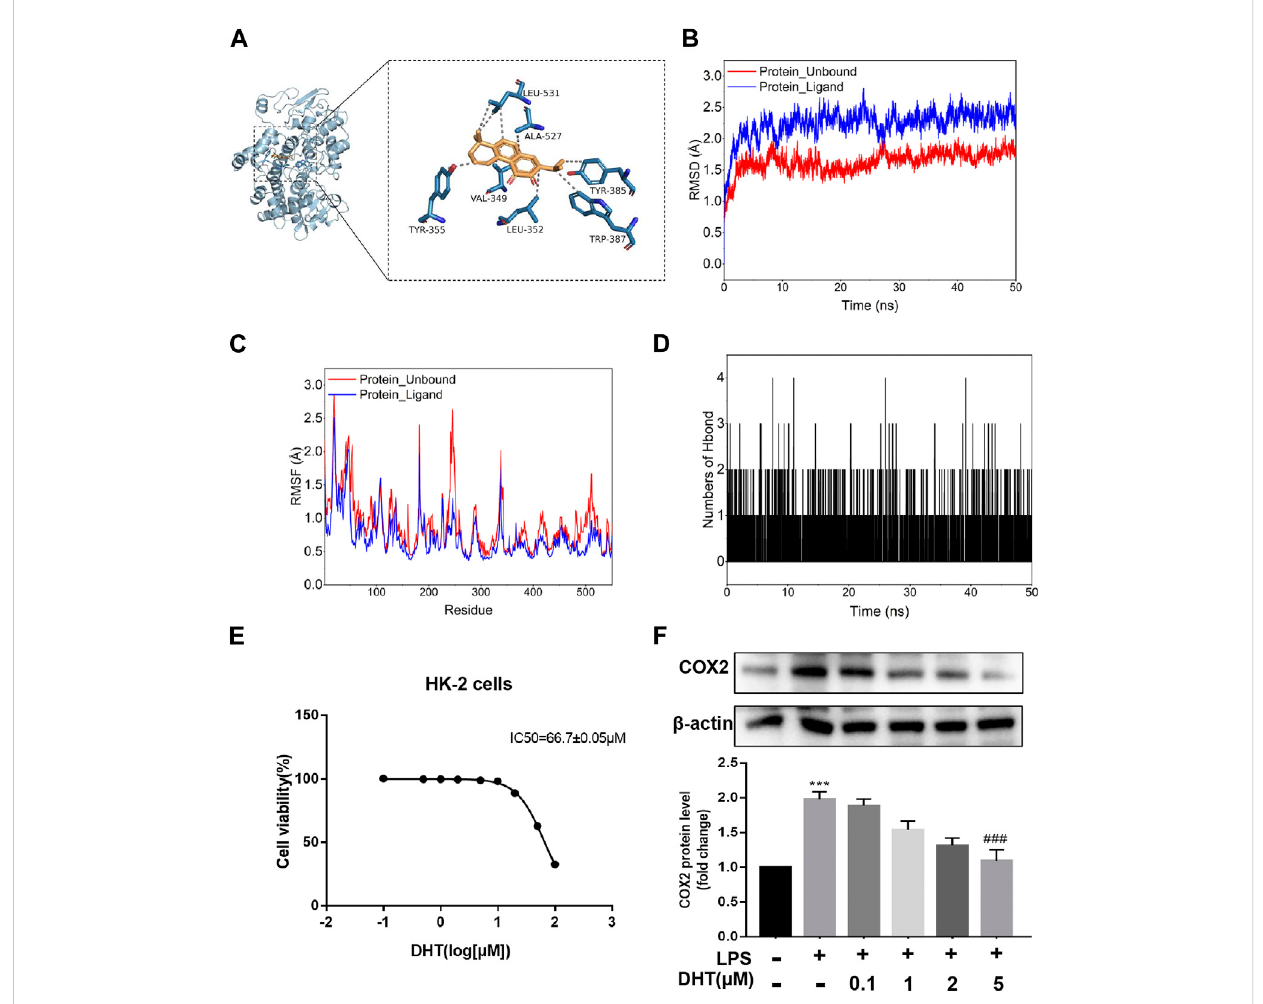
FIGURE 4 DockingpatternandmoleculardynamicssimulationofDHTbindingtoCOX2. (A) BindingmodelanalysisofDHTandCOX2.Theleftpanelshowsthe overall view, while the right panel shows the local view. The orange stick represents DHT, the blue picture represents COX2, and the gray dotted line represents the hydrophobic effect. (B) RMSD of the DHT and COX2 complex with time in the molecular dynamics simulation. (C) RMSF of the DHT and COX2complexbasedonthemoleculardynamicssimulation. (D) Changesinthenumberofhydrogenbonds betweensmallmoleculesandproteins during the molecular dynamics simulations. (E) Cell viability was measured by performing a CCK-8 assay after incubating HK-2 cells at different concentrations of DHT for 24 h. The IC 50 value of DHT is 66.7 ± 0.05 μ M. (F) Representative Western blot and quantitative data showing different concentrations of DHT on COX2 expression in LPS-induced HK-2 cells (n = 3). *** p < 0.001 vs. Con, ### p < 0.001 vs. LPS.